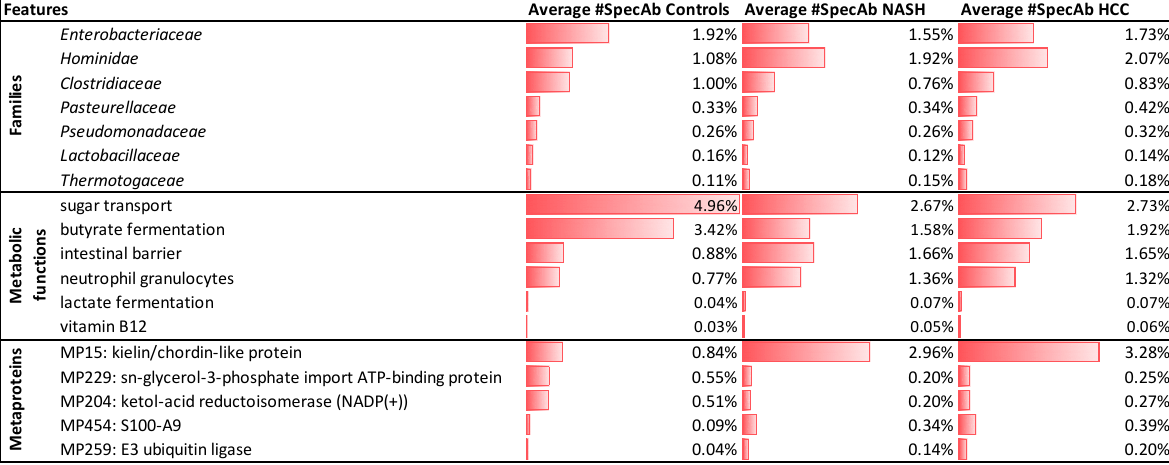
Table 1. Potential biomarker metaproteins between controls and diseased patients. We analyzed the ROC plot analysis for the most abundant ten metaproteins and summarized the area under the curve to evaluate metaprotein biomarkers.